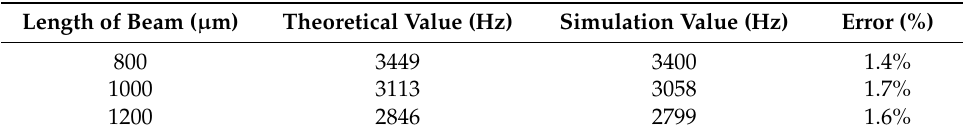
Table 2. The effects of the length of the beam on the resonant frequency.